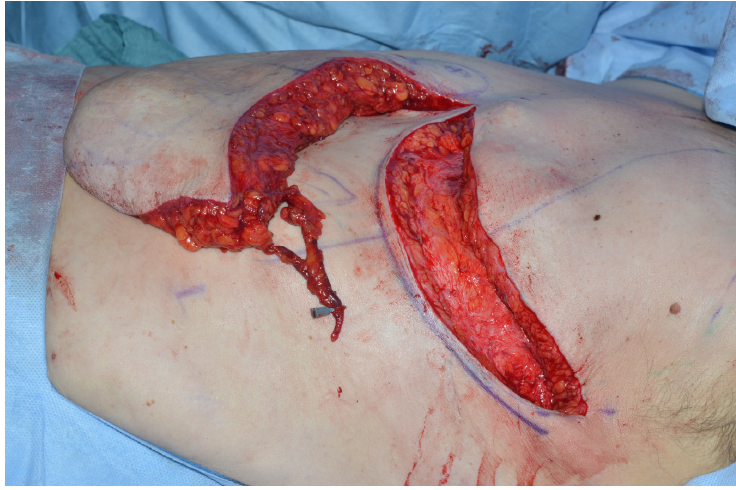
Figure 8. Dissection of a branch of the thoracoepigastric vein for venous supercharging of the distal third of the IMAP-flap.